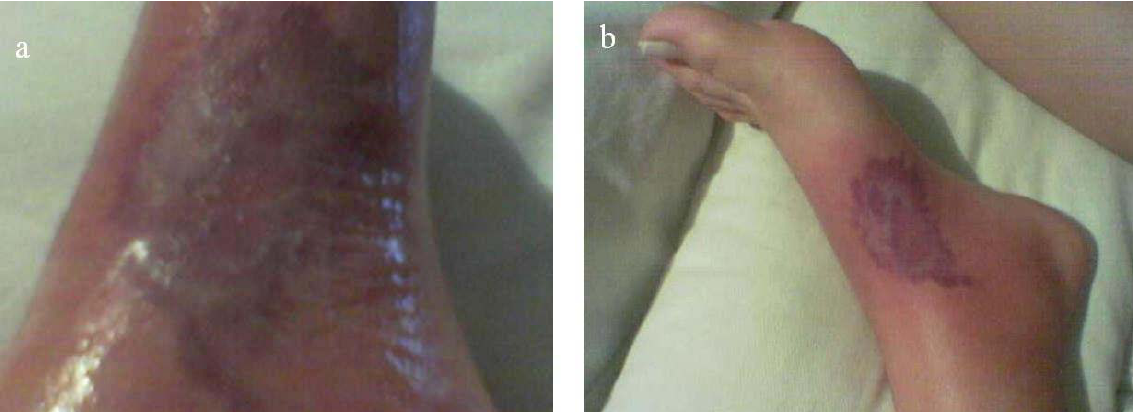
Figure 2. The wound caused by the spider bite on the seventh (a) and tenth (b) day after the